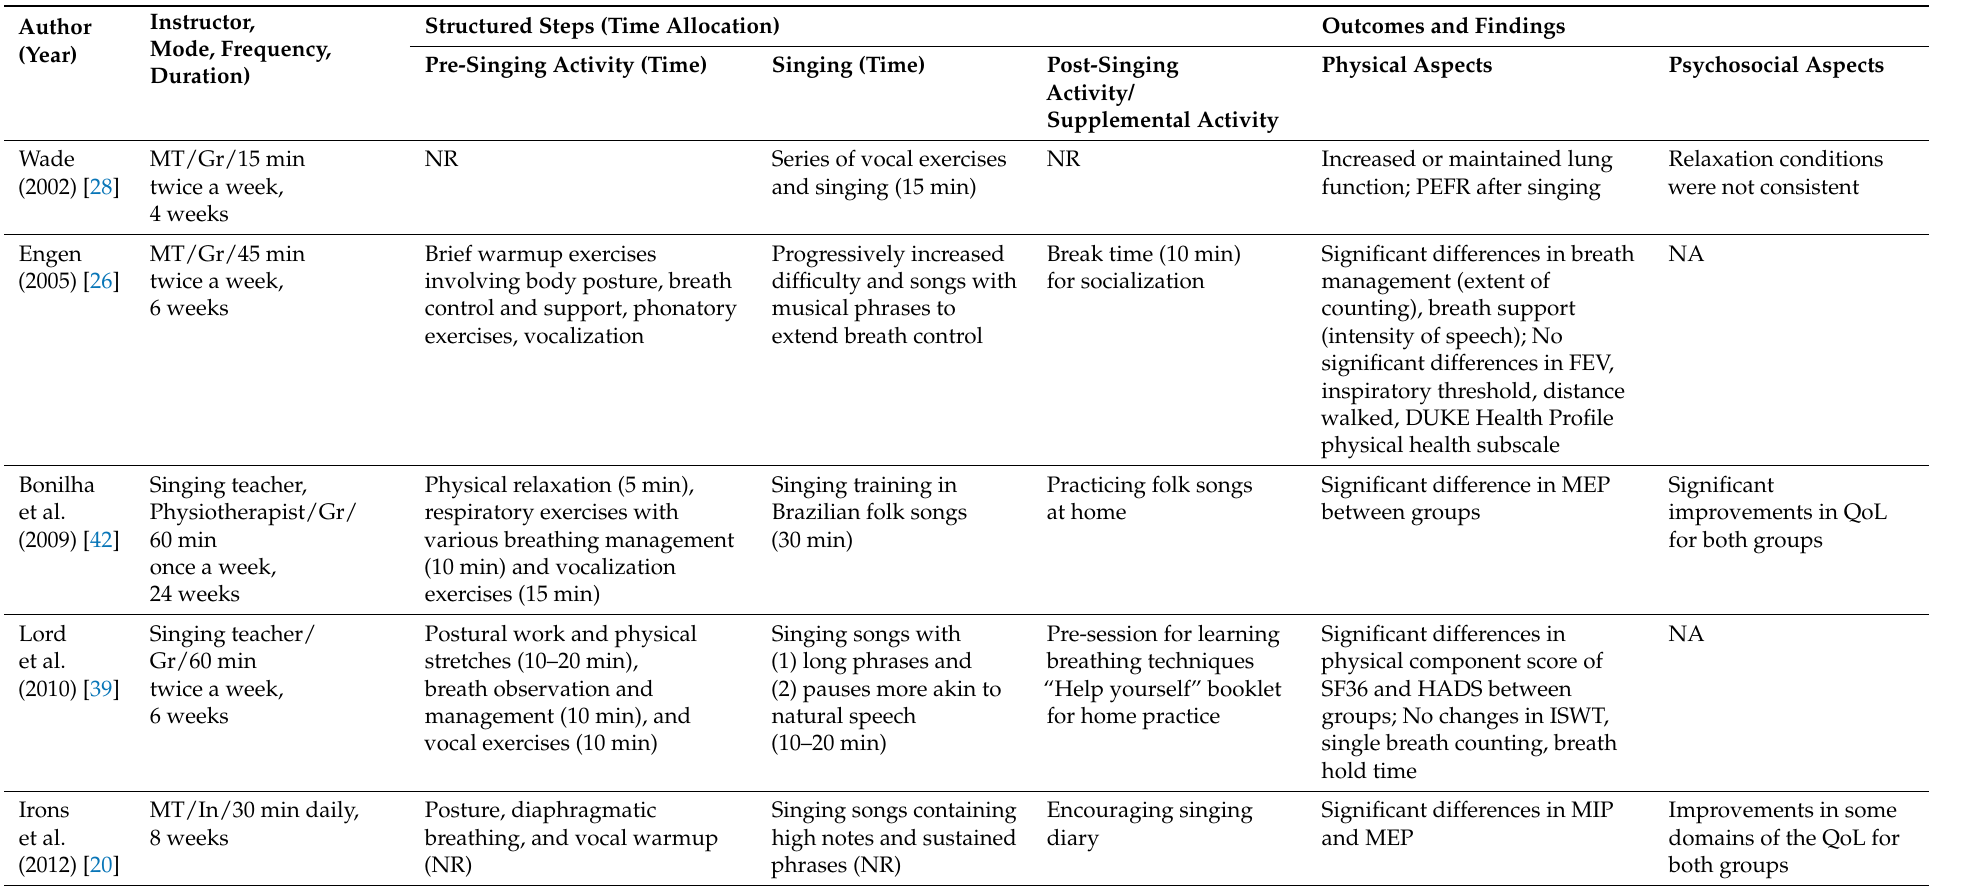
Table 1. Intervention characteristics, outcomes, and